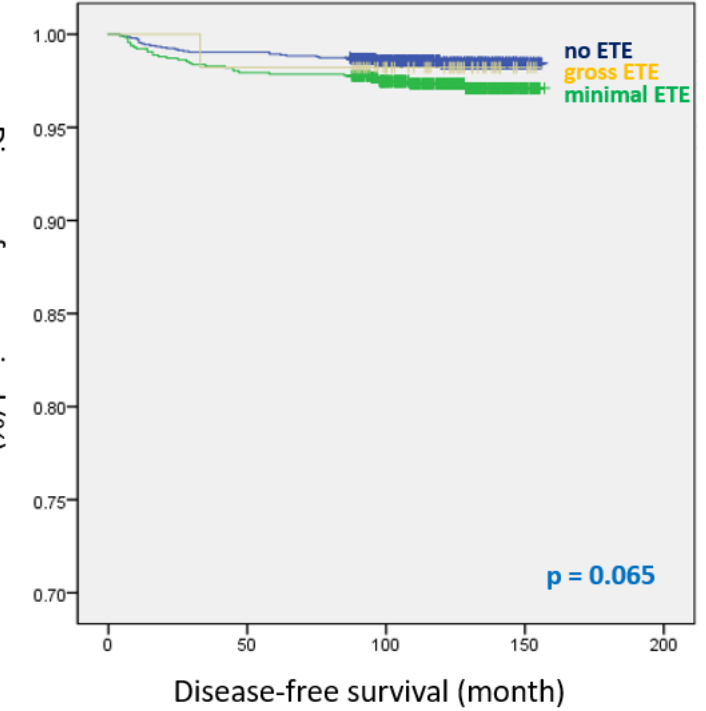
Figure 3. Disease-free survival curves of the three groups in papillary thyroid microcarcinoma (log-rank p = 0.065). Table 6 . Univariate and multivariate analyses of risk factors for recurrence in PTMC.